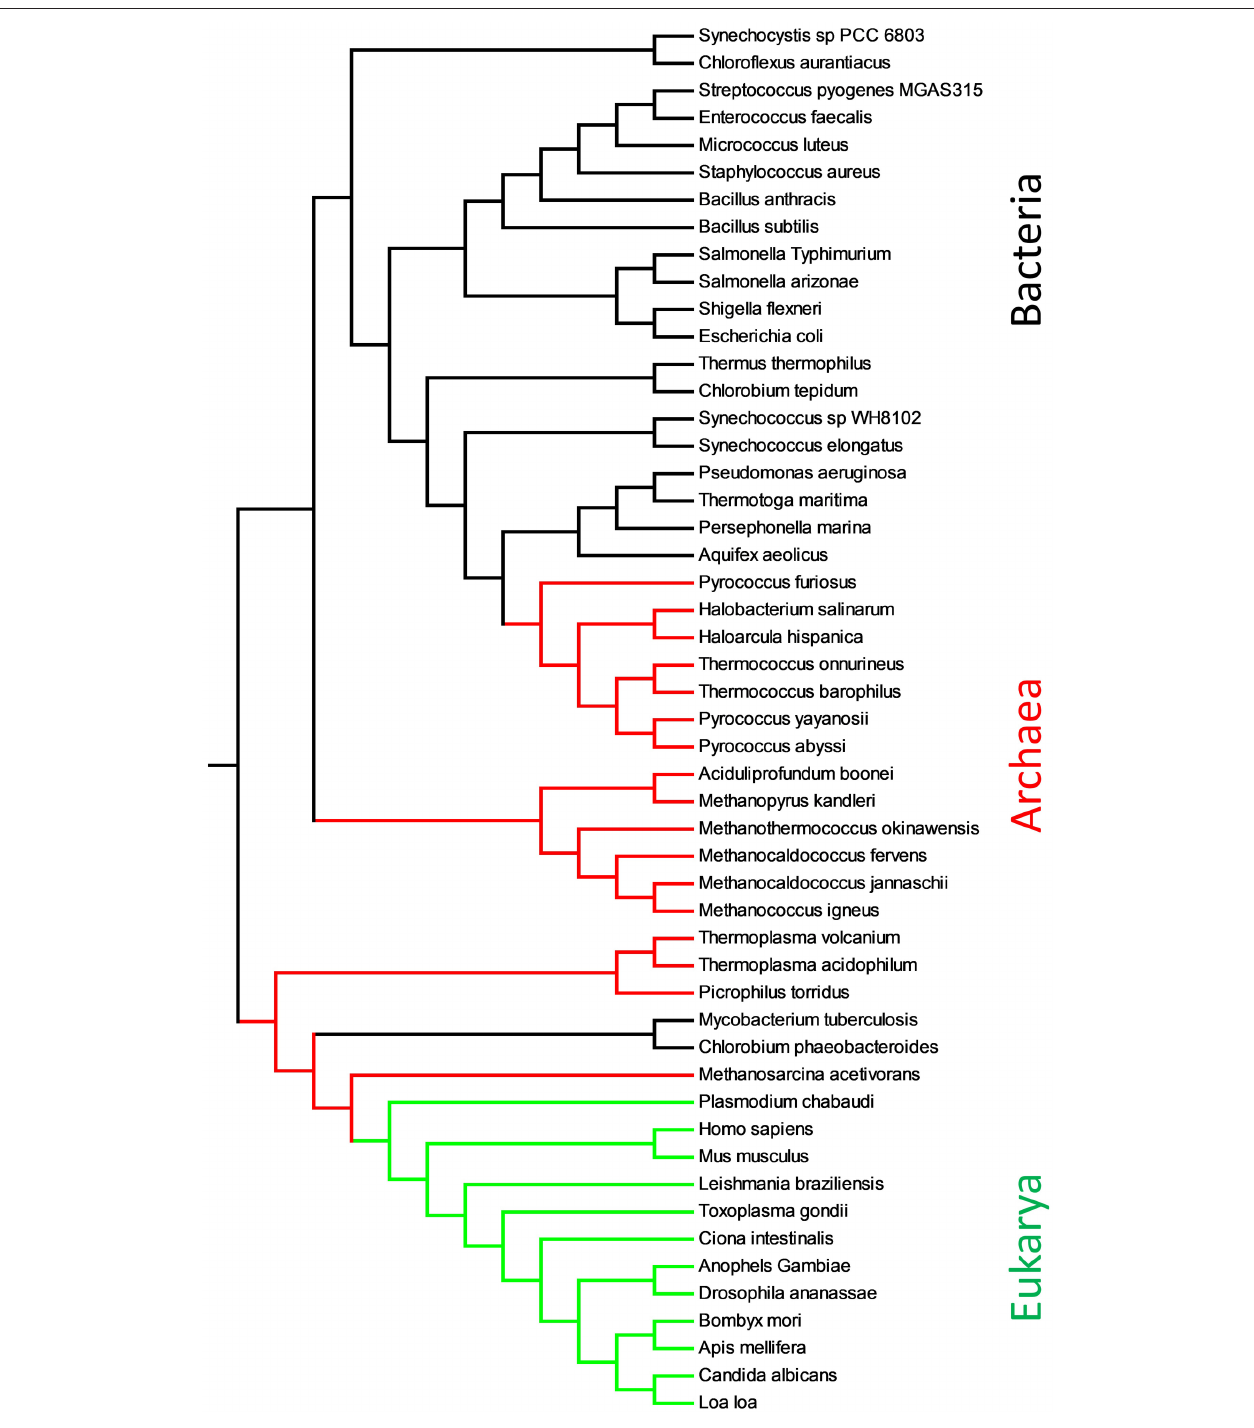
FIGURE 4 | Evolutionary relationships of proteomes obtained with Equation (2) and substring length between 6 and 12. Eukarya are shown in green, Bacteria in black and Archaea in red.